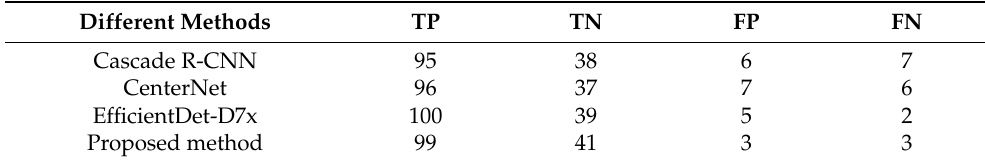
Table 6. The number of four possible